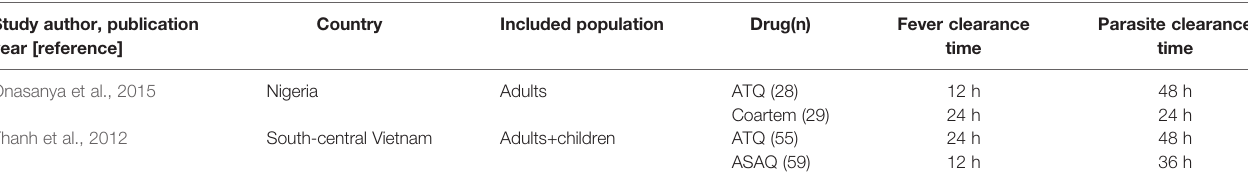
TABLE 3 | Parasite and fever clearance time (h) of two